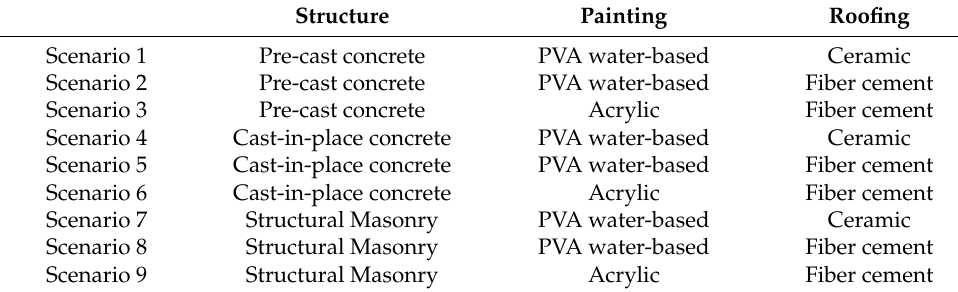
Table 1. Scenarios